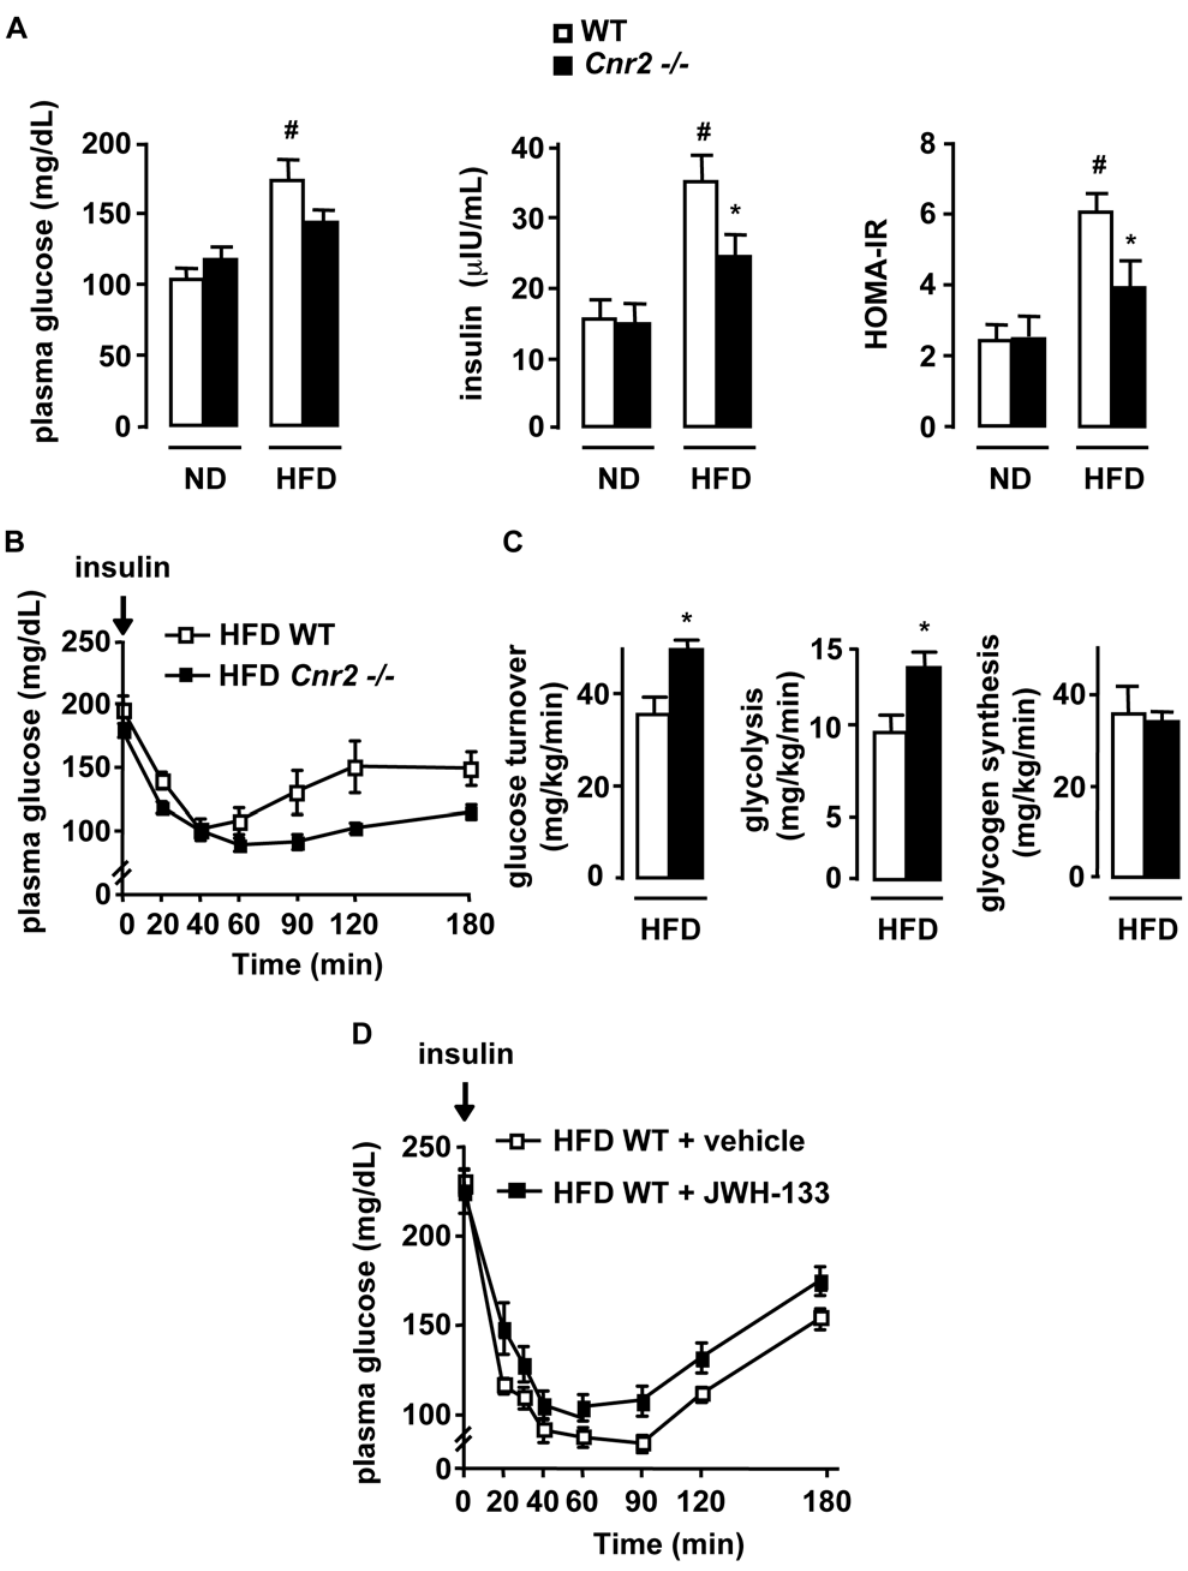
Figure 5. CB2 receptors potentiate insulin resistance in HFD-fed mice. A–C, Cnr2 knock-out reduces obesity-induced insulin resistance. WT and Cnr2 2 / 2 mice were fed a ND or a HFD for 15 weeks A, Fasting glycemia, insulinemia, HOMA-IR; B, Blood glucose level during insulin tolerance tests in HFD-fed mice (p , 0.05 by two way ANOVA). C, Hyperinsulinemic-euglycemic clamp in HFD-fed mice, as assessed by glucose turnover rate, whole body glycolysis and glycogen synthesis, following insulin stimulation. D, CB2 receptor activation increases insulin resistance. Blood glucose